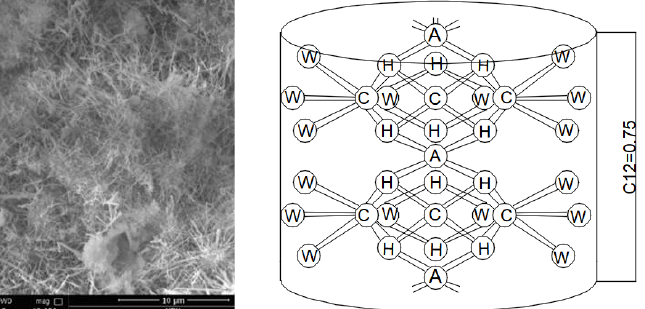
Figure 22. XRD pattern of high-water filling material before and after the hydration reaction, ( a ) before the reaction; ( b ) after the reaction [27].